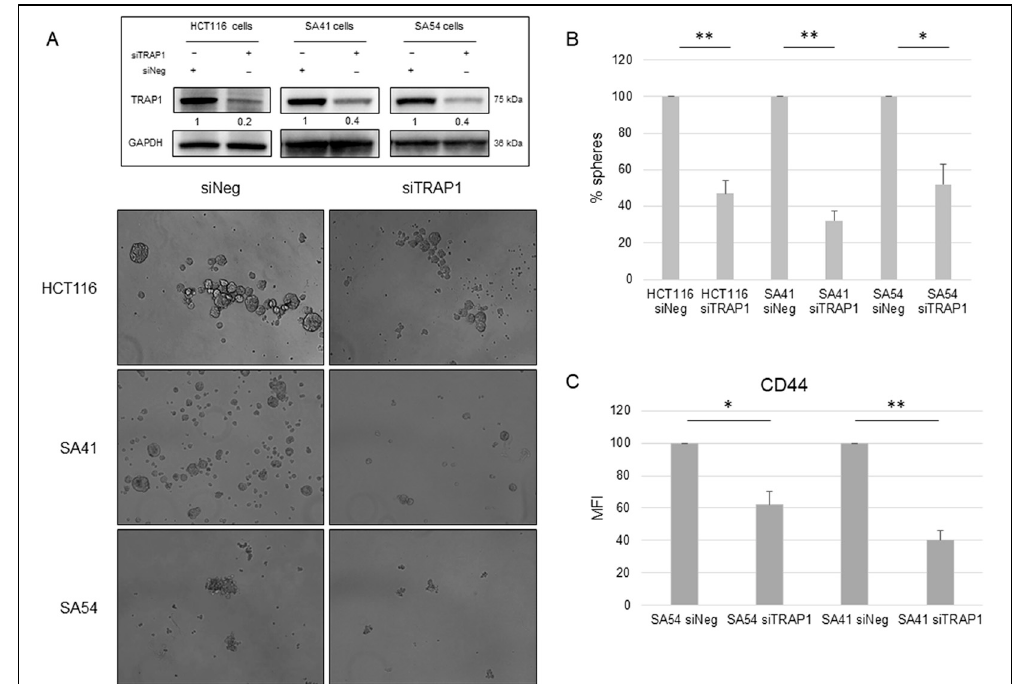
Figure 2. TRAP1 enhances the sphere-forming ability of colon carcinoma and cancer stem cells. ( A , B ) Representative images ( A ) and quantitative representation ( B ) of the sphere-forming ability in control (siNeg) and TRAP1-silenced (siTRAP1) HCT116, SA41 and SA54 cells. Statistical significance respect to the respective siNeg control: * p < 0.05; ** p < 0.01. Data represent means + S.D. ( A ) Insert: TRAP1 immunoblot analysis in siNeg and siTRAP1 HCT116, SA41 and SA54 cells. ( C ) Relative CD44 MFI levels in control (siNeg) and TRAP1-silenced (siTRAP1) SA41 and SA54 cells evaluated by CD44 immunostaining and subsequent flow cytometry. Statistical significance respect to the respective siNeg control: * p < 0.05; ** p < 0.01; n/s. Data represent means + S.D. MFI, Mean Fluorescence Intensity.